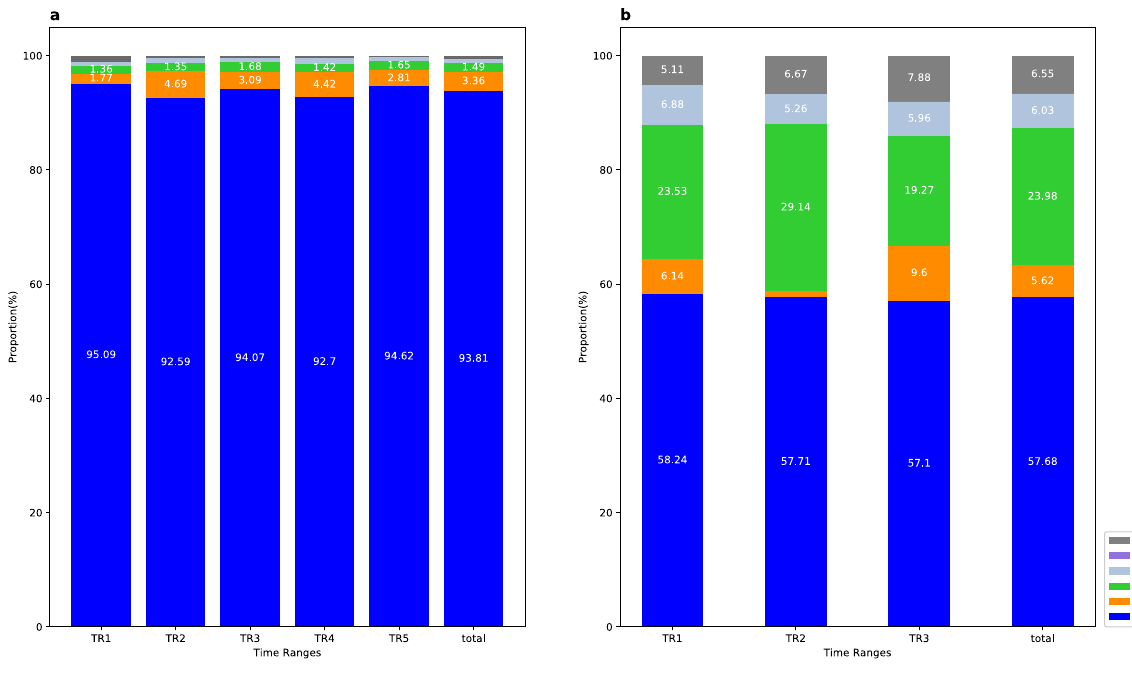
Figure 2. Proportions of different distribution types in different time ranges. Different colors in each bar represent the proportions of different distribution types. The number in each color indicates the percent corresponding to this color. Five best-fitting distributions, that can fit more than 0.1% of travel speed variables in either road network type, are identified. ‘None’ indicates the proportions of travel speeds that do not follow any of the 4 distributions. ( a ) Urban road network. ( b ) Freeway network.